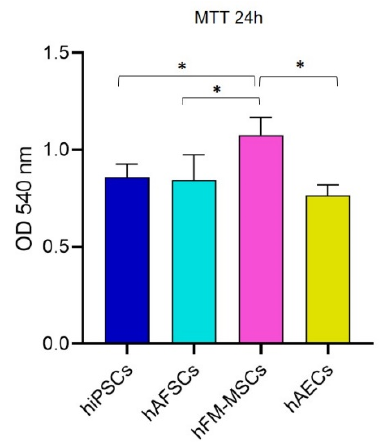
Figure 7. MTTassayforhiPSCs, hAFSCs, hFM-MSCs, andhAECs. Thecellswereseededat15.625cell / cm 2 Figure 7. MTT assay for hiPSCs, hAFSCs, hFM ‐ MSCs, and hAECs. The cells were seeded at 15.625 and after 24 h they were treated with 0.5 mg / mL MTT for 4 h. The absorbance is expressed as measure cell/cm 2 and after 24 h they were treated with 0.5 mg/mL MTT for 4 h. The absorbance is expressed as of cell viability and their basal metabolism. The graphs show the mean ± SD of 5 independent measure of cell viability and their basal metabolism . The graphs show the mean ± SD of 5 independent experiments, * p < experiments, * p < 0.05.